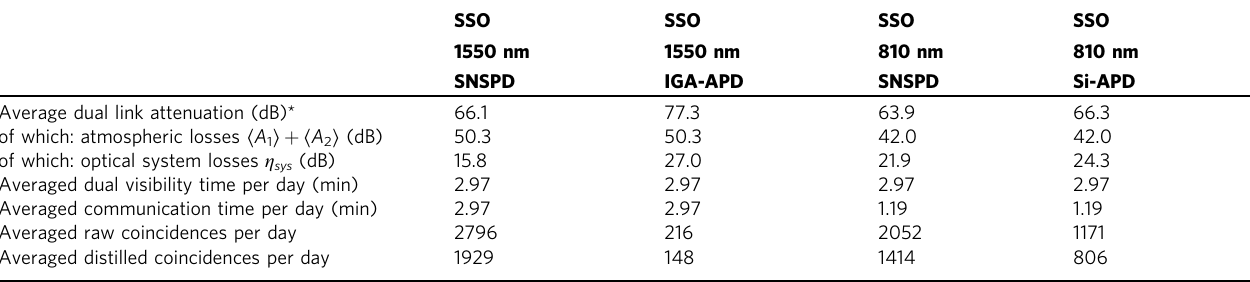
Table 4 Simulations results for a (frozen) Sun synchronous LEO orbit at 600 km height with an inclination of 97.8